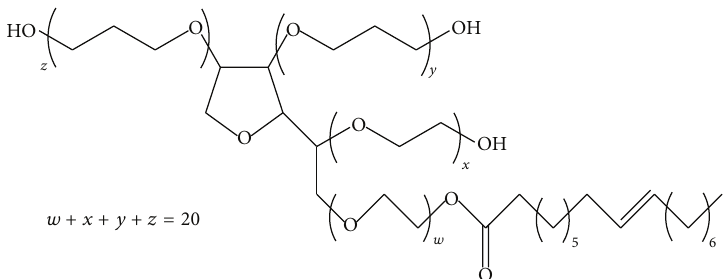
Figure 3: Structure of Tween-80.